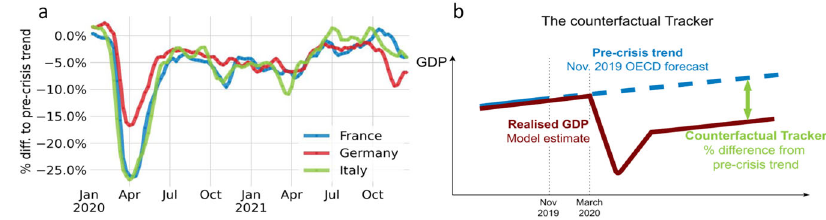
Fig. 5 The OECD weekly tracker. a OECD Weekly Tracker for France, Germany, and Italy 40 . b Schematic depiction of the OECD Weekly Tracker that is providing a proxy of weekly GDP relative to the pre-crisis trend based on Google Trends search data and machine